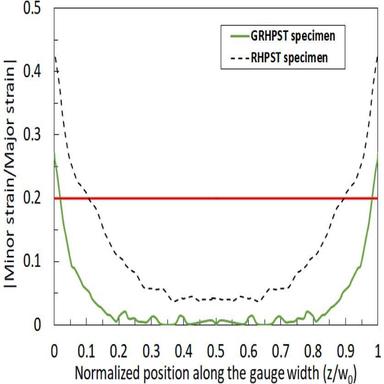
⃒ ⃒εmin/εmaj ⃒ ⃒ across the normalized position along the gauge width of the RHPST (black dashed curve) and the GRHPST (green curve) specimen's (εmaj = 0.3 in the centerof the gauge section). The threshold 0.2 line is plotted (red line) to delimit the plane strain state region from the uniaxial tension region.